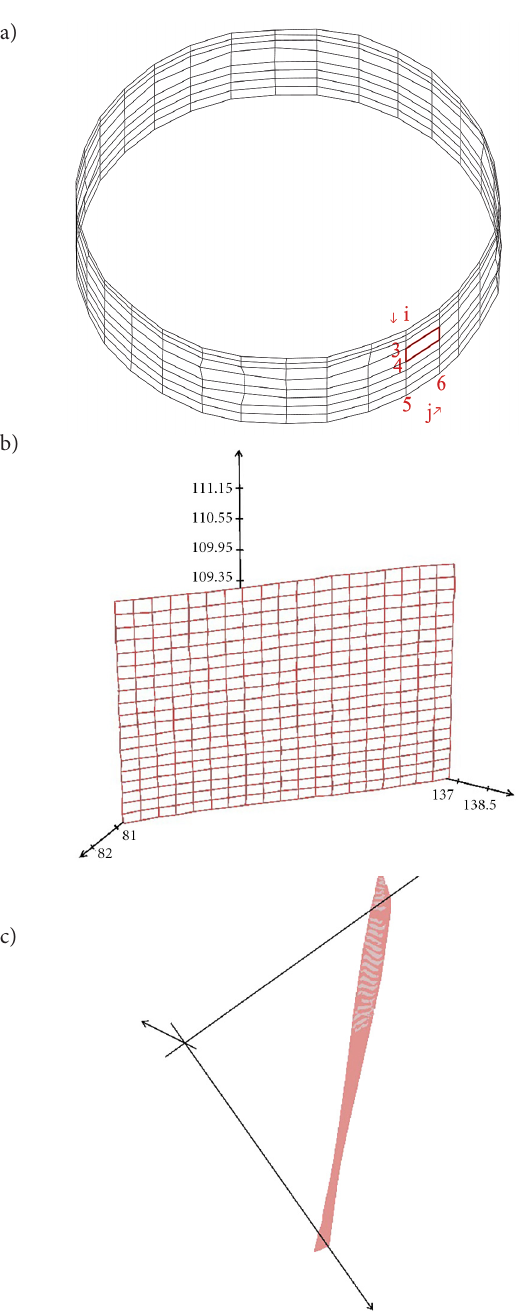
Figure 5. a) 3D visualization of the surface of the VST 75.000 m 3 LODS “Brody”; b) a fragment of the interpolation bicubic Hermite surface for the region i = 3 j = 5; c) the top